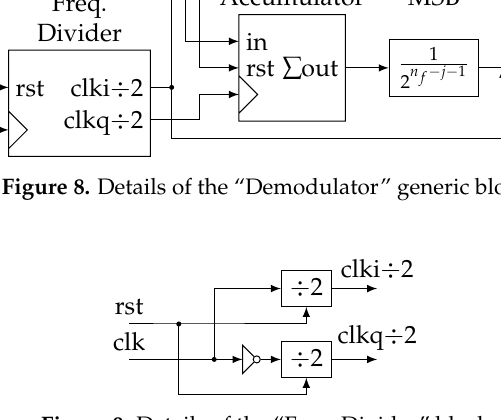
Figure 9. Details of the “Freq. Divider” block.